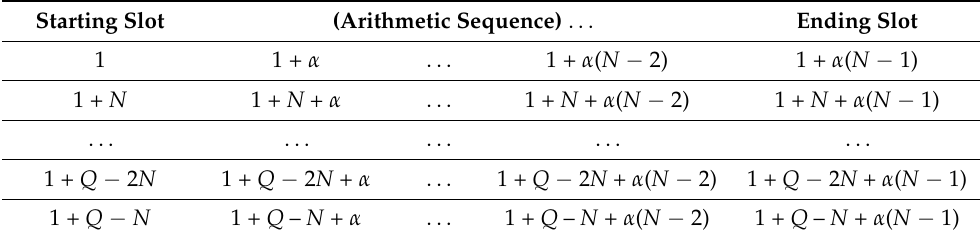
Table 1. Slot sorting of CBW and UBW.